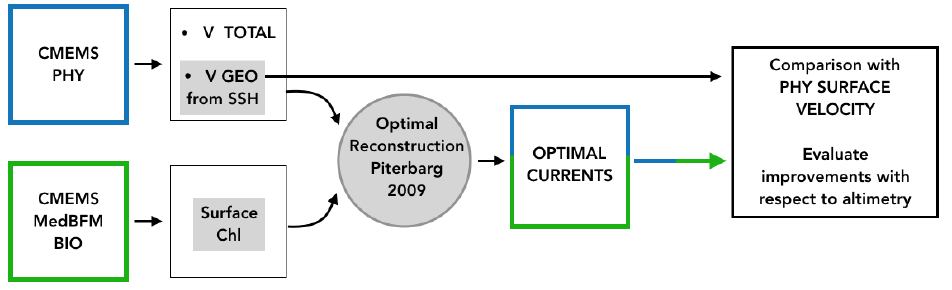
Figure 2. Workflow of the OSSE, covering the entire year 2017. The CMEMS PHY and BIO models are used to generate synthetic altimeter-derived geostrophic currents and satellite-derived Chl concentrations in the Mediterranean Sea, as detailed in Section 2.1. Then, the optimally reconstructed currents (OPtimal Currents, OPC hereinafter) are computed according to the PIT09 equations (provided in Section 2.3) for the entire year 2017 and compared to the PHY model surface layer outputs (our ground- truth current field). In this way, a direct comparison of the 2D Eulerian currents can be carried out, enabling to have equally significant statistics for every grid point of our study